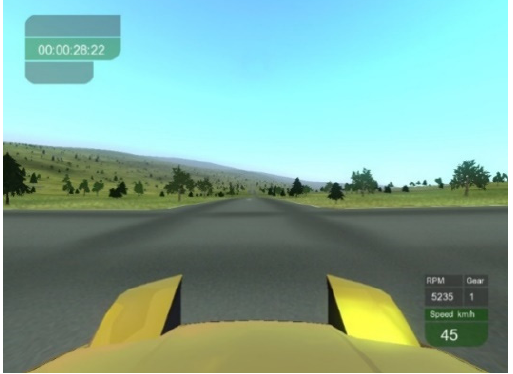
Figure 1. A typical scene as a driver neared a crossroads.